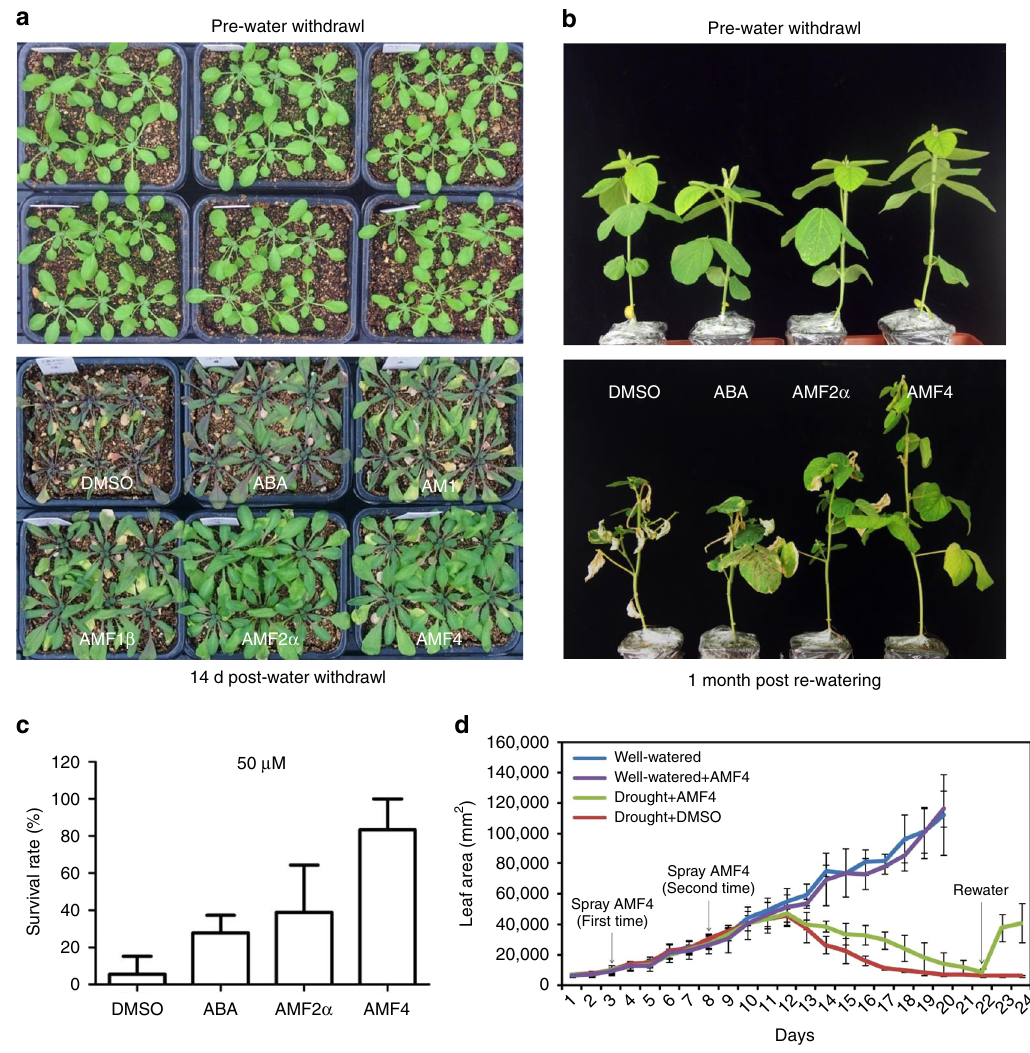
Fig. 6 AMFs increase the drought resistance of Arabidopsis and soybean plants. a AMF treatments increase drought resistance of Arabidopsis . Wild-type (Col-0) plants are grown under short-day conditions for 2 weeks before watering is stopped. The plants are subsequently treated with DMSO (control), or 10 μ M (+)-ABA, AM1, or AMFs once per week for another 2 weeks before watering was resumed. The plants are photographed before watering was stopped (top panel) and 14 days after watering is stopped (bottom panel). b AMF4 treatments increase drought resistance of soybean plants. Williams 82 soybean plants at the triple trifoliate stage are subjected to drought (watering was stopped), and then are sprayed twice at 3-days intervals with DMSO (control) or 50 μ M (+)-ABA, AMF2 α , or AMF4 in 1 week period before watering is resumed. The plants are photographed before watering is stopped and 1 month after watering is resumed. c Survival rates of plants in b are calculated 1 month after watering is resumed; plants are considered to have survived if they have new leaves emerging. Values are the mean survival rates from 15 individual plants per treatment, and error bars indicate SD. d The growth of soybean is monitored by measuring the area of all leaves. Eight-day-old Williams 82 soybean plants are subjected to drought (watering was stopped), and their leaf areas are recorded by a camera. The plants are sprayed with DMSO or AMF4 (20 μ M) at 3 and 8 days after watering is stopped. For the well- watered condition, the plants are watered every 3 days. Error bars indicate the standard deviation of four biological